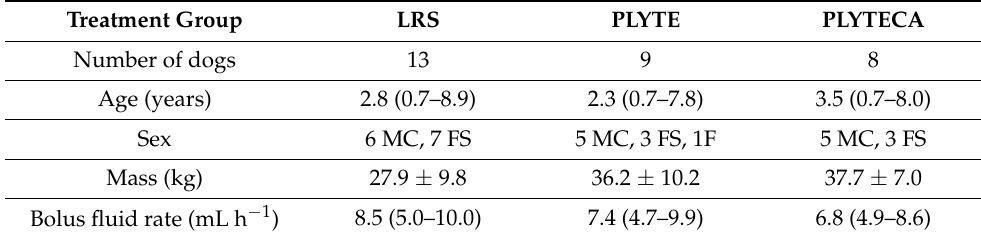
Table 2. Demographic data for dogs in each treatment